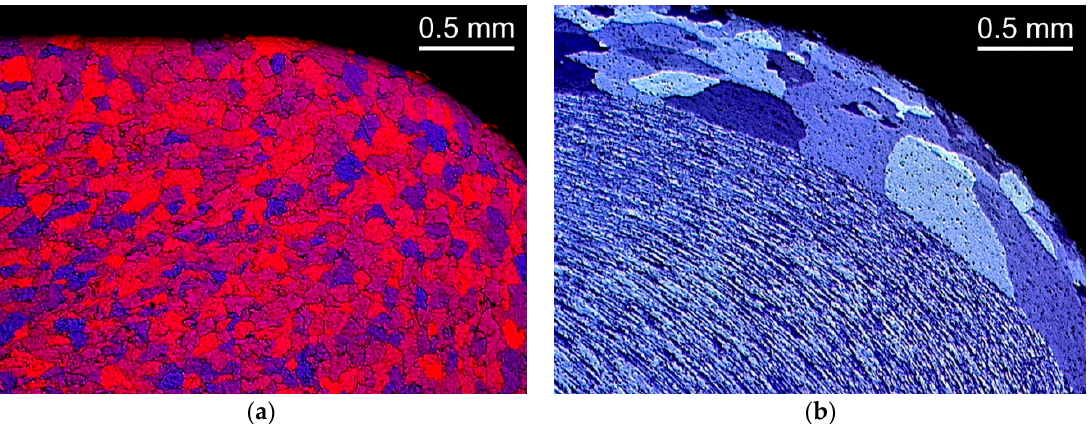
Figure 13. Effect of the initial structure state on the forged microstructure of the 6082 alloy [46]. ( a ) Forging from the cast non-homogenized rod–surface area. ( b ) Forging from the extruded rod and the coarse-grained recrystallized surface